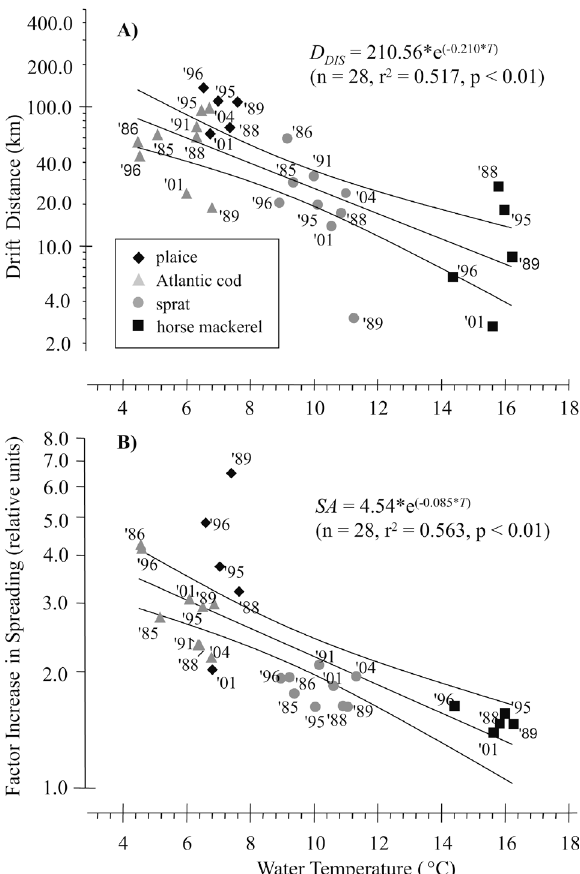
F IG . 5. – Changes in drift distance (km) (Panel A) and factor in- crease in dispersion area (final area divided by release/spawning area) (Panel B) versus water temperature for plaice (diamonds), At- lantic cod (triangles), sprat (circles), and horse mackerel (squares). Regression equations are for the pooled data. Note that the ordinate axis has a log scale in both panels.